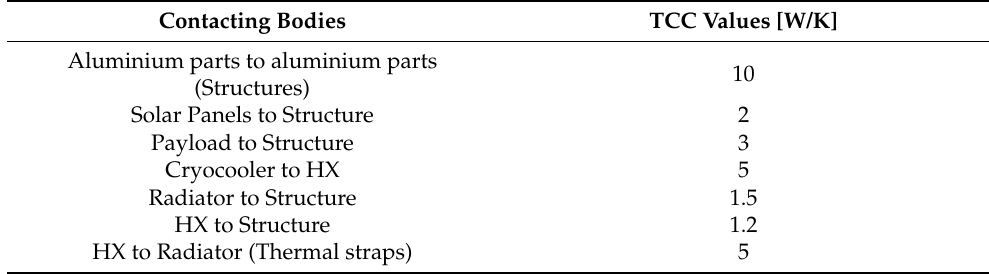
Table 6. Thermal contact conductance.